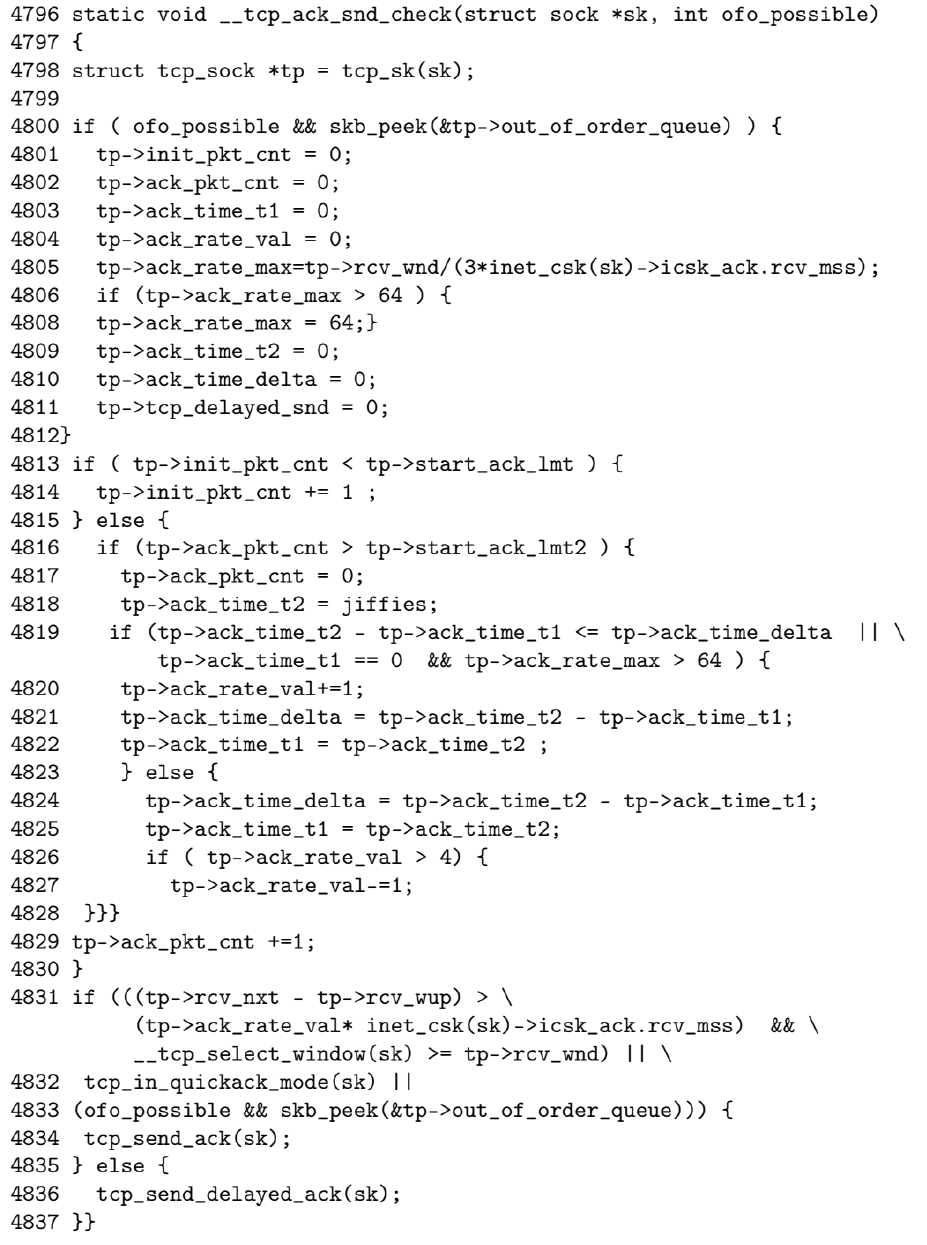
Figure 2. Modified Linux kernel tcp_input.c source code of __tcp_ack_snd_check() for checking TCP session